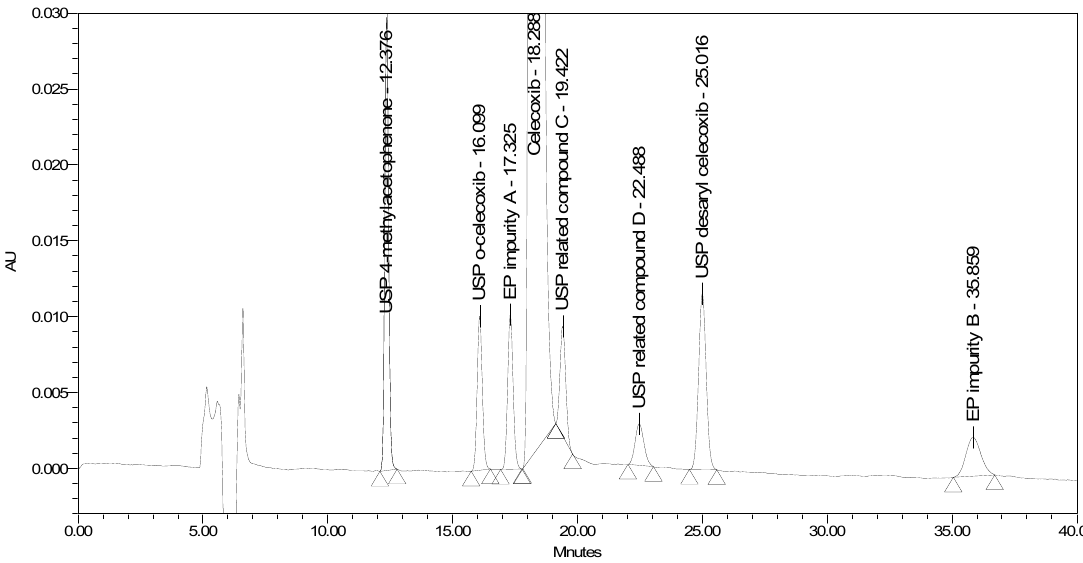
Figure 5. A chromatogram of celecoxib at a concentration of 0.5 mg/mL spiked with seven process-related impurities at the 0.5% level obtained using Chiralpak IA-3 with initial chromatographic conditions.